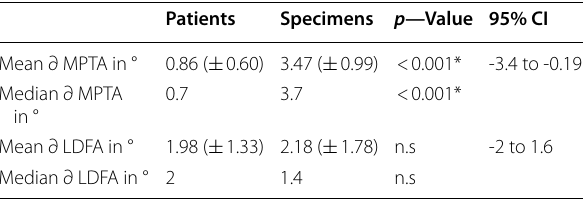
Table 3 Statistical analysis of the absolute delta between the mean and median of the planned alignment and the radiological